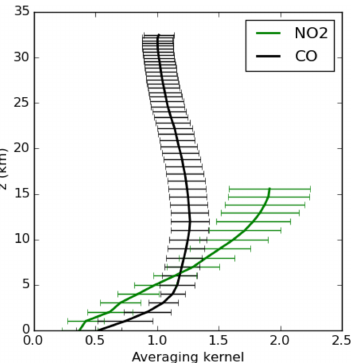
Figure 2. TROPOMI averaging kernels ( A ) for CO total column and tropospheric NO 2 over Mexico City on 1 June 2018. The error bars represent the standard deviation of the mean A at each vertical